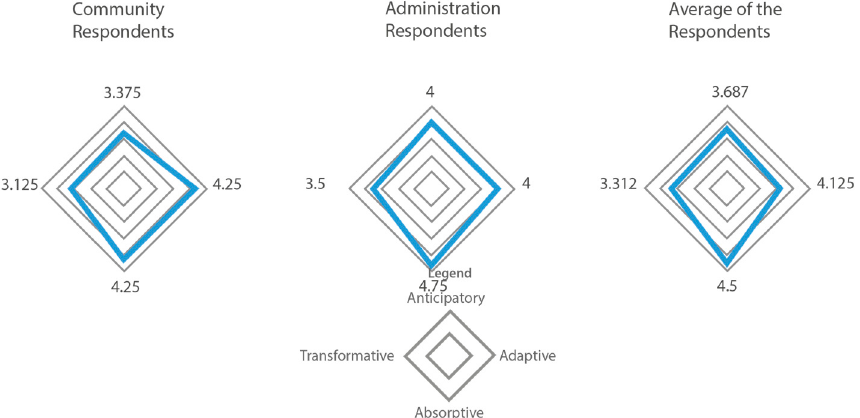
Figure 5. Average of the capacities in Japan ((on a Likert scale of 1–5, with 5 representing the highest score).